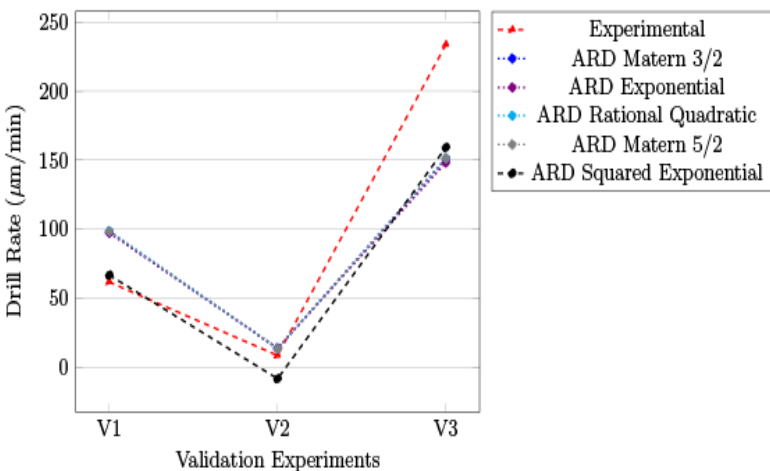
Figure 7. GPR model testing for DR with different kernels.